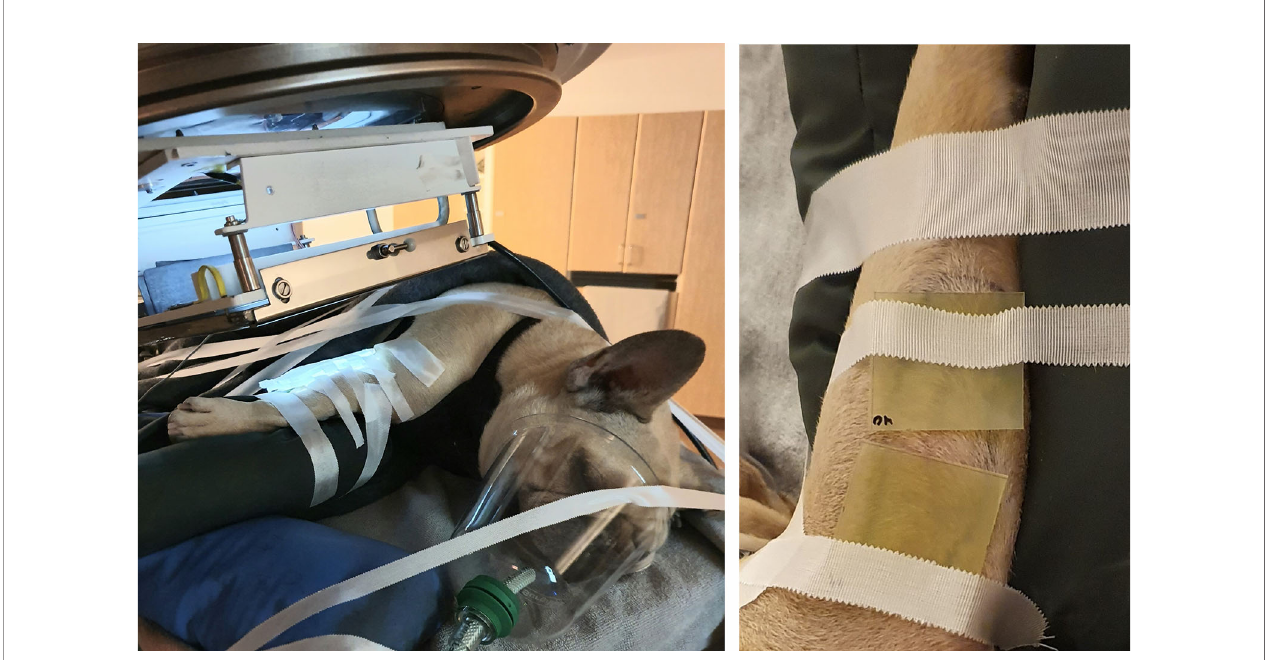
FIGURE 2 | The treatment setup for patient no. 1 (left panel), with a source-to-surface distance of 70 cm and a Cerrobend plate to collimate the 8x4 cm 2 radiation fi eld. During the treatment, in vivo fi lm measurements (right panel) were performed at the skin surface of the patient to verify the delivered